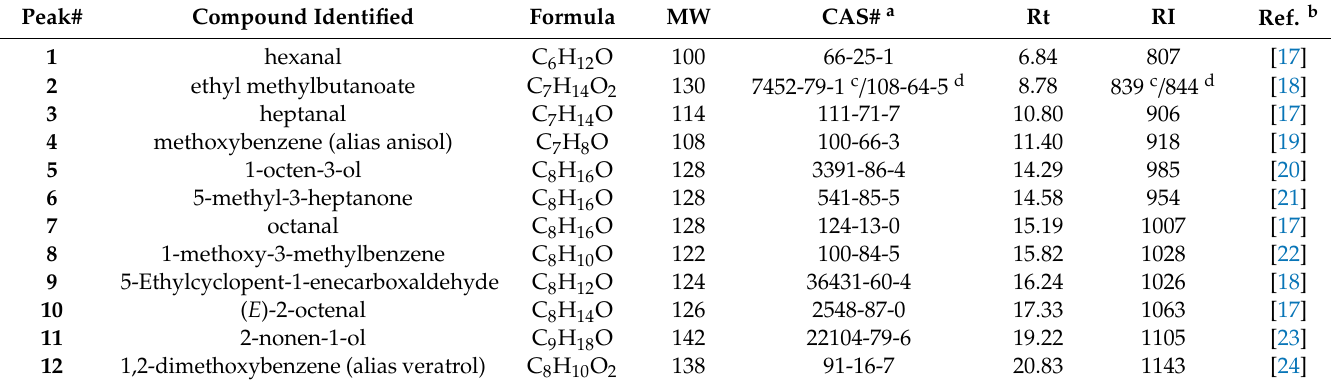
Table 2. Most representative volatile compounds determined with HS-SPME-GC / MS. All the compounds were identified by mass spectrometric fragmentation, retention time (Rt), and retention index (RI). The compound no. 1 , 2 , 3 , 4 , 5 , 6 , 7 , 8 , 12 were identified by also injecting the standard